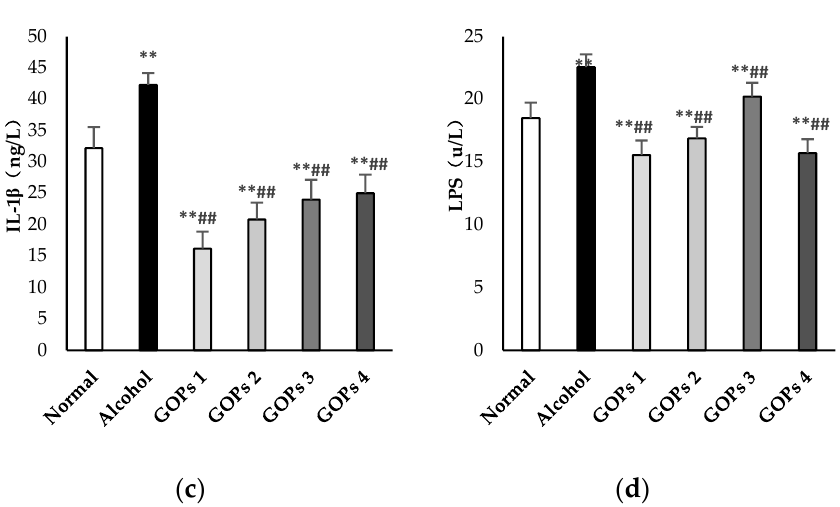
Figure 3. Effects of GOPs on inflammatory cytokine and lipopolysaccharide levels in rats. Values are presented as the mean ± standard deviation of 10 rats per group. ( a ), tumor necrosis factor- α (TNF- α ); ( b ), interleukin (IL)-6(IL-6); ( c ) interleukin (IL)-1 β (IL-1 β ); and, ( d ), lipopolysaccharide (LPS). * p < 0.05 versus control group, ** p < 0.01 versus control group; # p < 0.05 versus alcohol group, ## p < 0.01 versus alcohol group. GOPs, small molecule oligopeptides isolated from ginseng; GOPs 1 to 4 refer to administration of GOPs at a dose of 0.0625, 0.1250, 0.2500, 0.5000 g/kg, respectively.